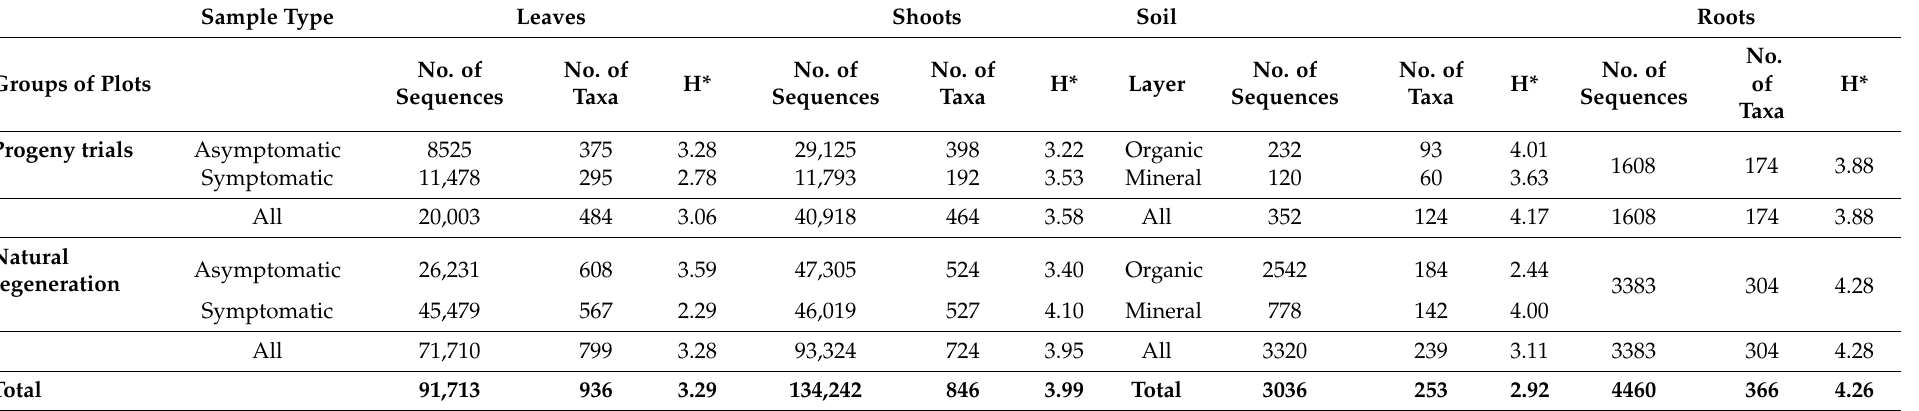
Table 3. Generated high-quality sequences and detected diversity of fungal taxa in samples of different types in trials and natural populations of Fraxinus excelsior in Lithuania.